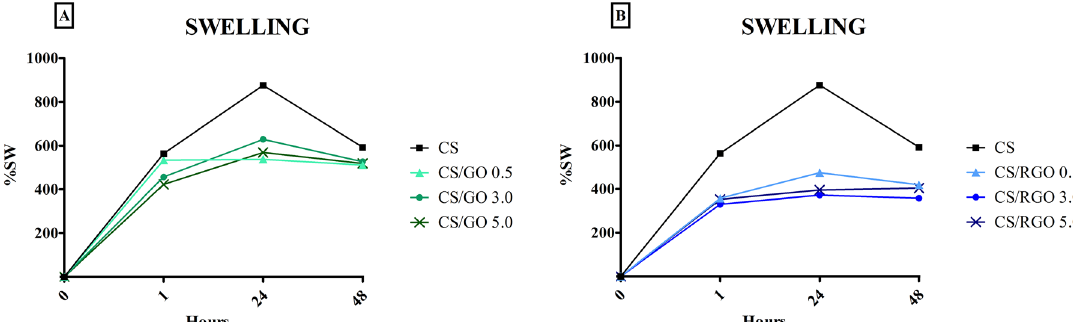
Figure 5. Comparative graph of Swelling Degree (%SW) between pristine and filled chitosan membranes: (A) CS/GO and (B) CS/RGO.